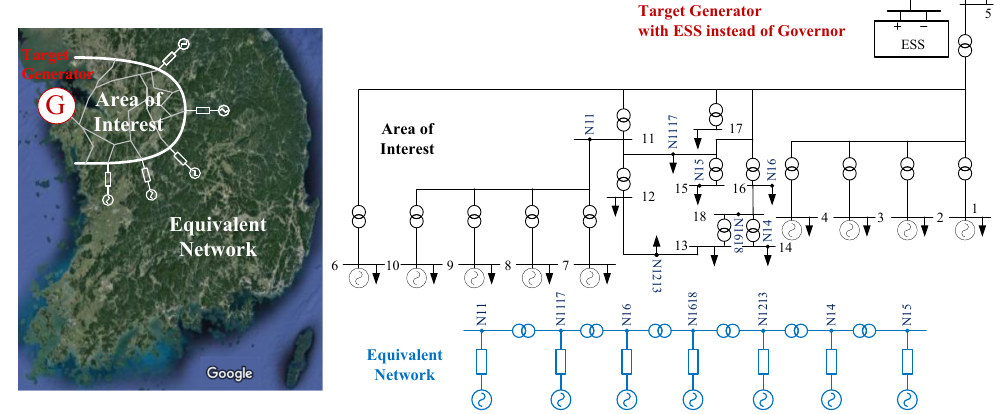
Figure 12. Real Korean power network using model reduction method (source: Google Maps).